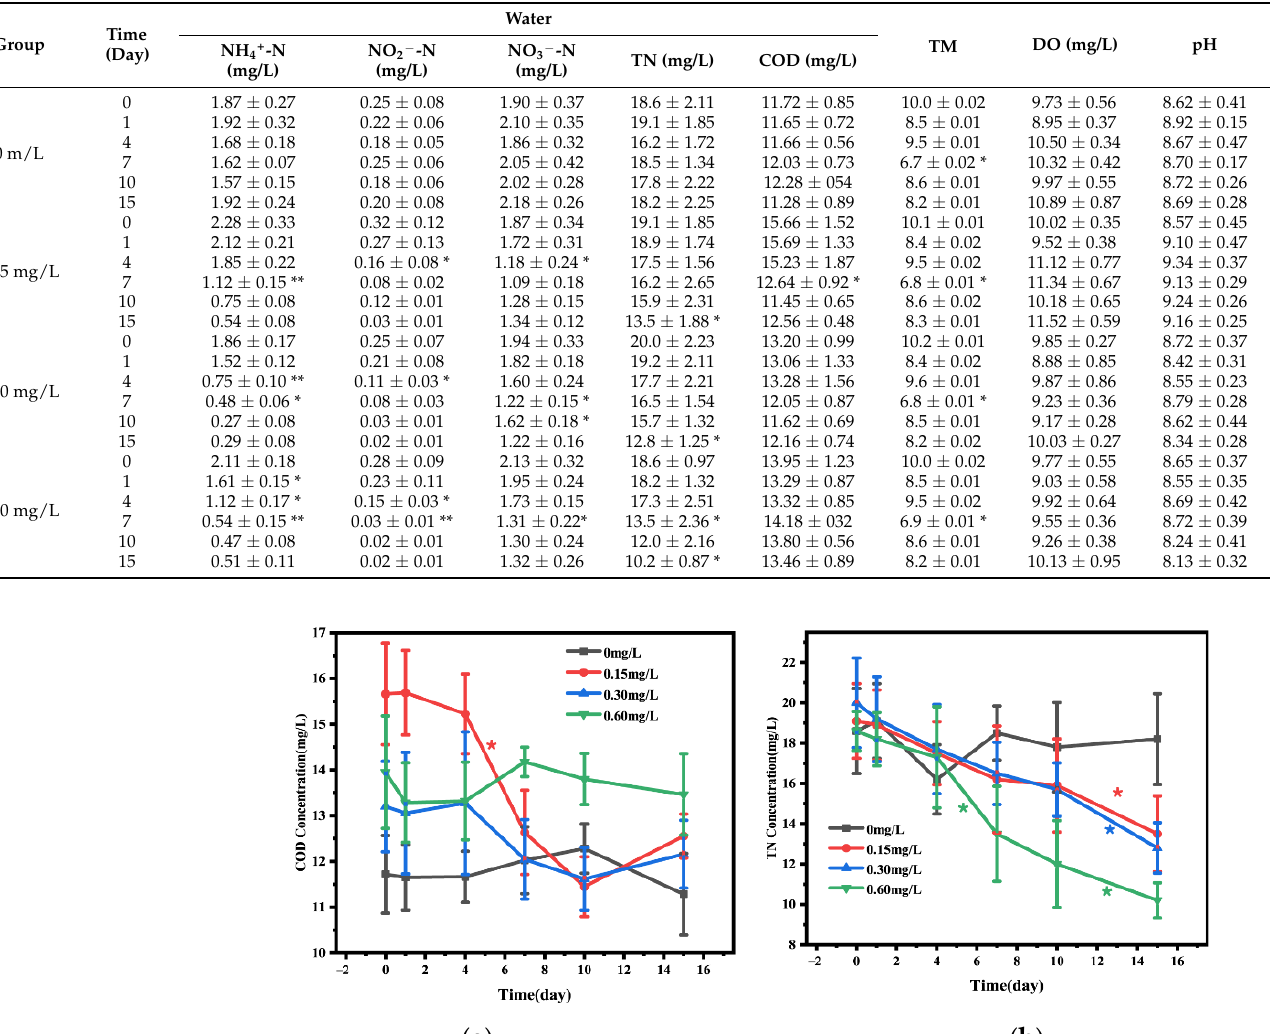
Table 1. Physicochemical characteristics of the water samples (the “*” expression p < 0.05, the “**” expression p < 0.01).